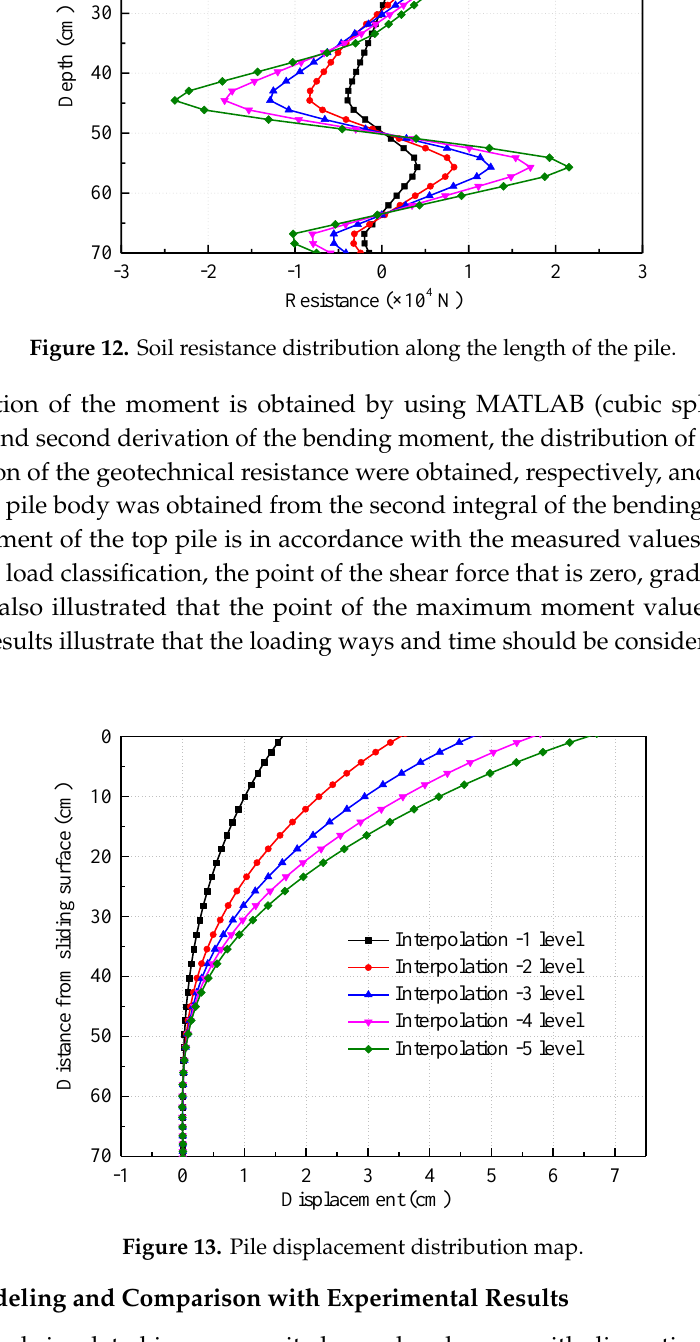
Figure 11. Shear force distribution along the length of the pile.